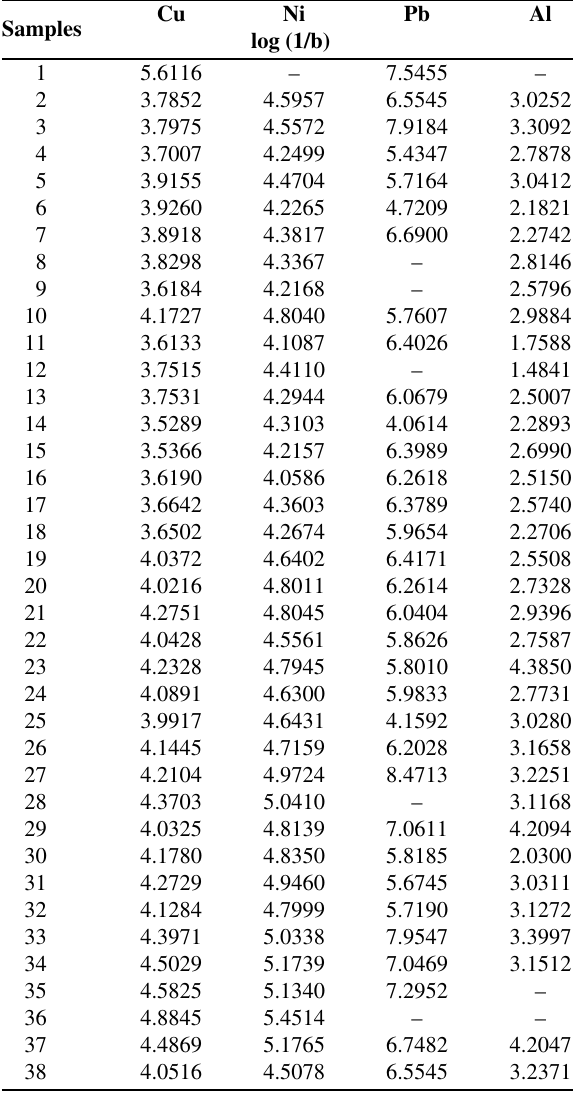
Table 1. The content of metals in the analysed chocolate samples (b – molality) Cu Ni Samples